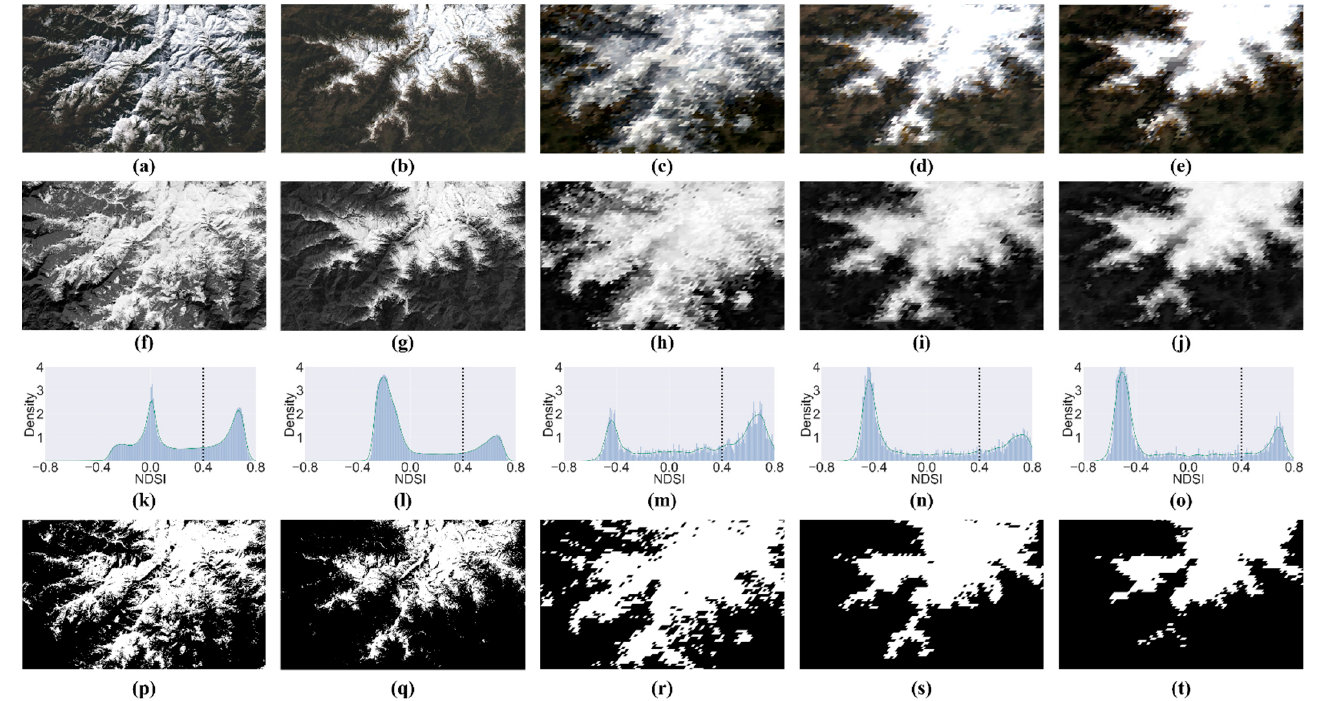
Figure 4. The process of generating the snow mask by using NDSI. Columns 1 and 2 show Landsat images at 𝑡 (cid:2869) and 𝑡 (cid:2870) . Columns 3, 4, and 5 show MODIS images at 𝑡 (cid:2869) , 𝑡 (cid:2926) , and 𝑡 (cid:2870) . ( a – e ) are the surface reflectance images; ( f – j ) are the NDSI images; ( k – o ) are the NDSI frequency histogram; ( p – t ) are the snow mask based on a threshold of